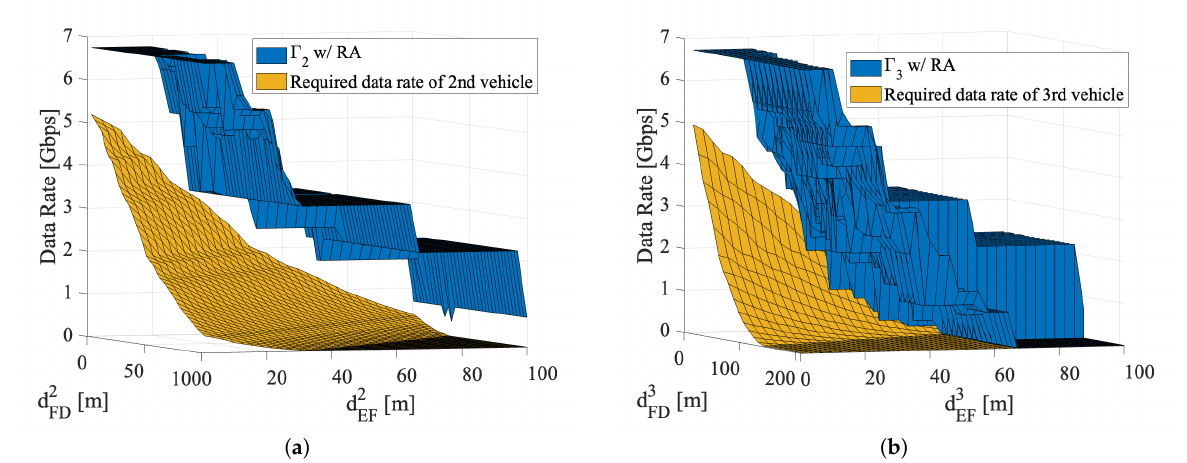
Figure 9. Comparison between achievable E2E throughput and required data rate with arbitrary inter-vehicle distance ( G t = G r = 30 dBi, p Mode1 = − 11 dBm, p Mode2 = 4 dBm, d switch = 36 m ( n = 1) ∈ ( 0,100 ] ). ( a ) Second vehicle; ( b ) third or 30 m ( n > 1 ) , B = 2.16 GHz, d n EF